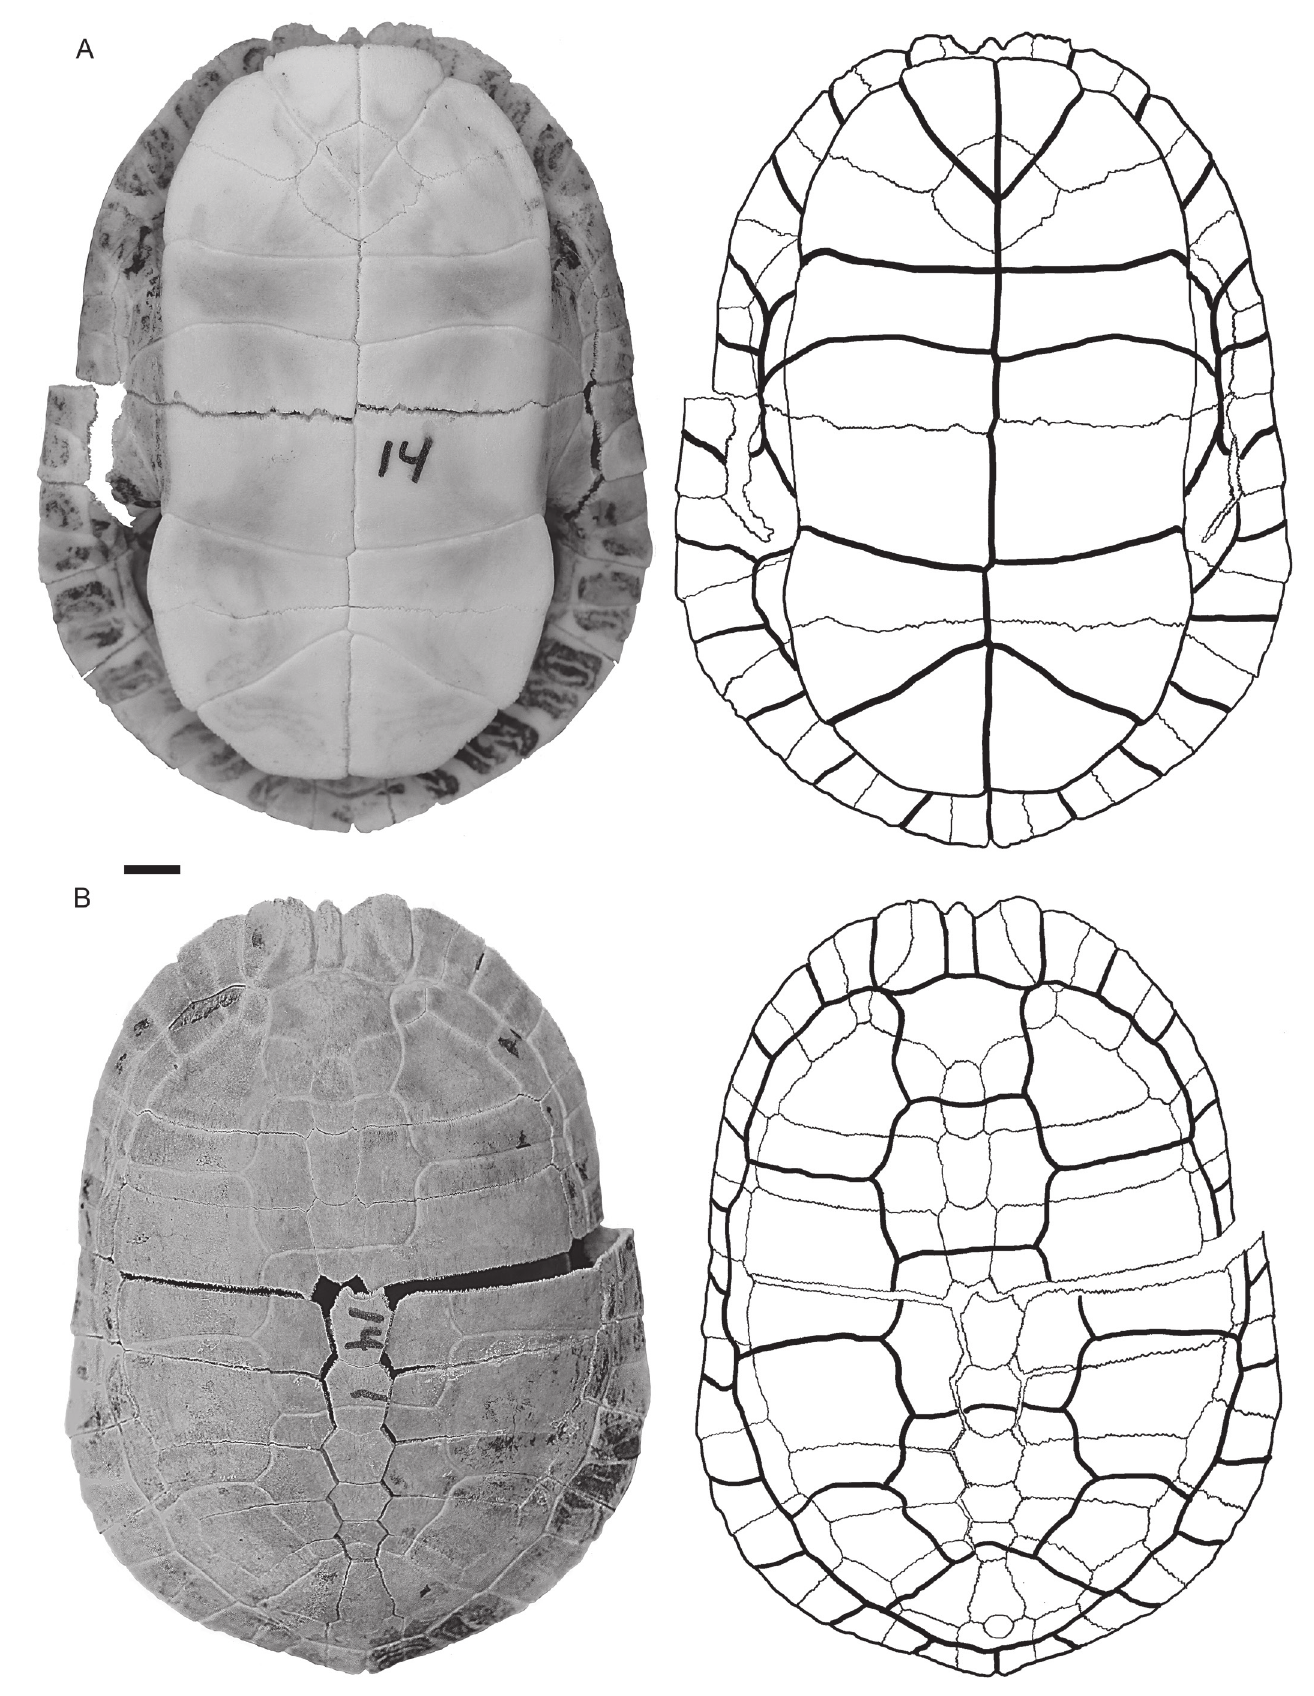
Figure 6. Chrysemys picta bellii, Neb 14. A, plastron and B, carapace. Scale bar = 1